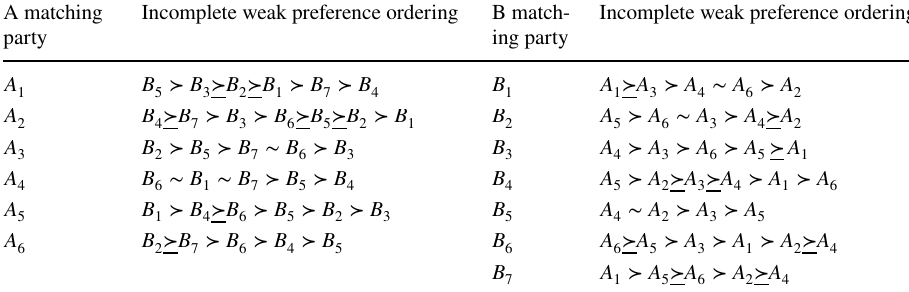
A matching Incomplete weak preference party